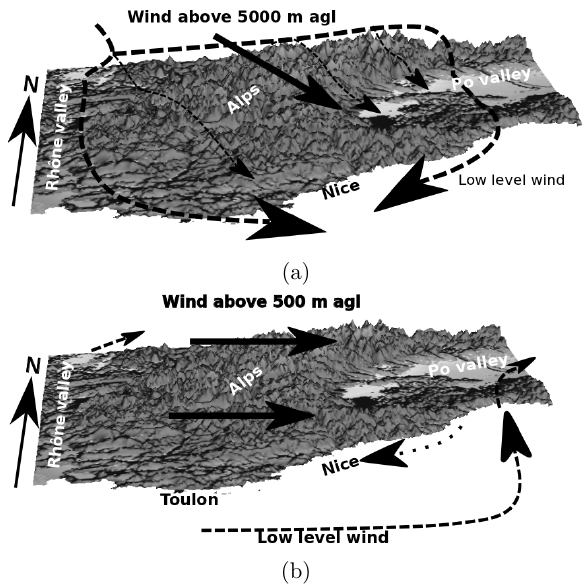
Fig. 6. Conceptual scheme of the “Alps crossing” case (a) and “vor- tex case” (b) . Plain arrows represents the winds above the boundary layer, dashed and pointed arrows are winds in the boundary layer.